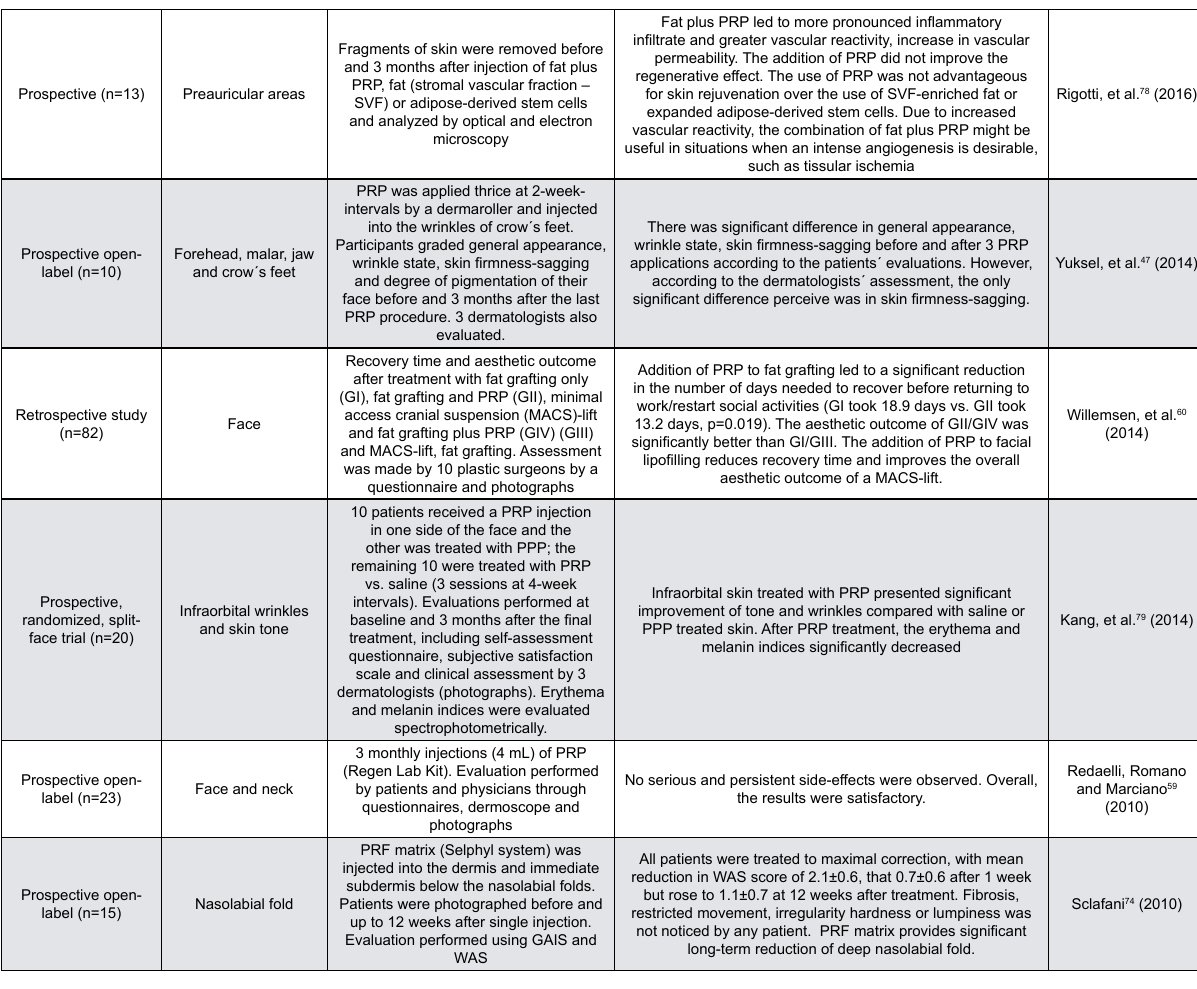
Figure 4- Clinical trials on the use of autologous platelet aggregates for facial rejuvenation skin.